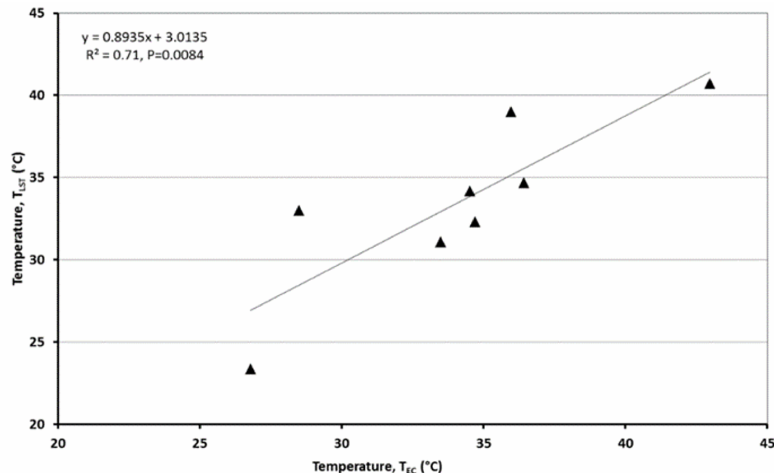
Figure 4. Comparison of EC measured ( T EC ) and remote sensing derived ( T LST ) surface temperature.